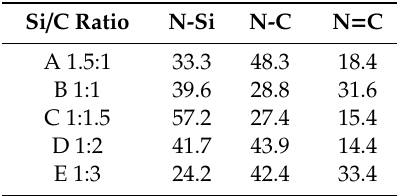
Table 4. The percentage of chemical bonds in N1s (%).